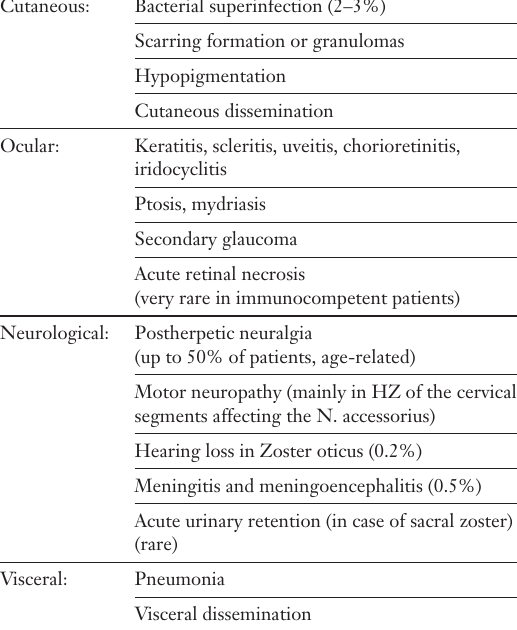
Table 4 Complications of Herpes zoster (frequency in